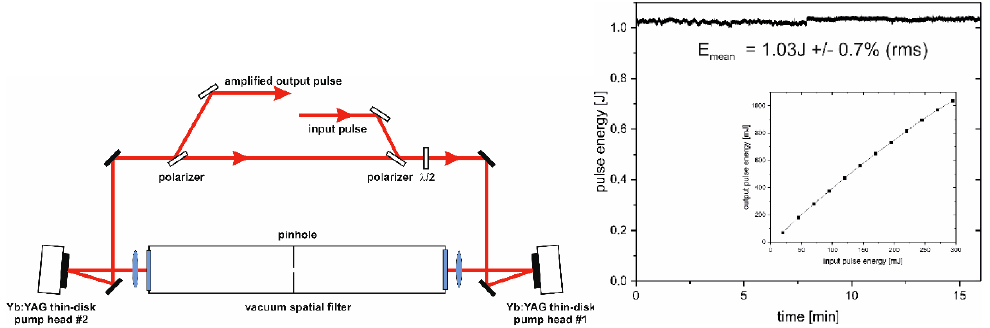
Figure 6. Sketch of the 1 J ring amplifier. Pulse energies of more than 1 J at 100 Hz repetition rate were demonstrated using two 6 kW pump diode modules at each amplifier head.